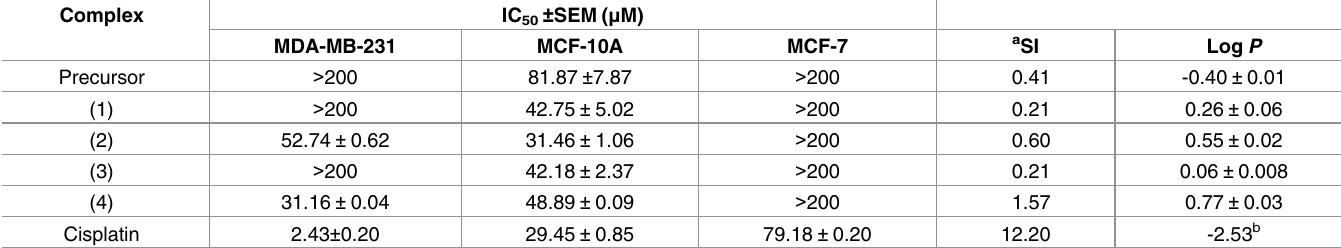
Table 1. IC 50 , SI and Log P values for complexes (1–4) and cisplatin in each cell line, after 24 h of incubation.